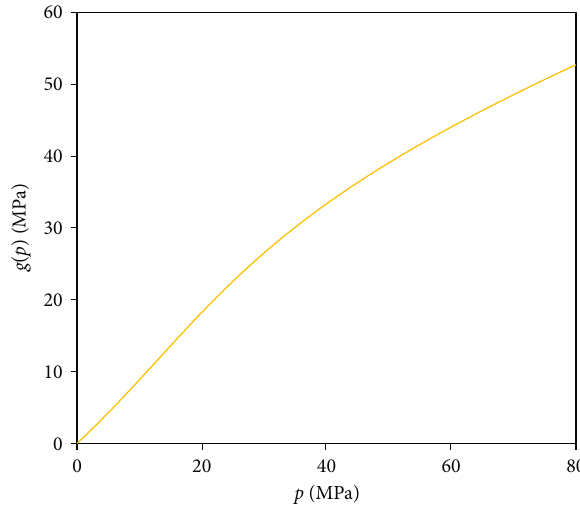
Figure 19: The relation curve of 1/ ð μ · C Þ vs. p for the high- pressure cases.